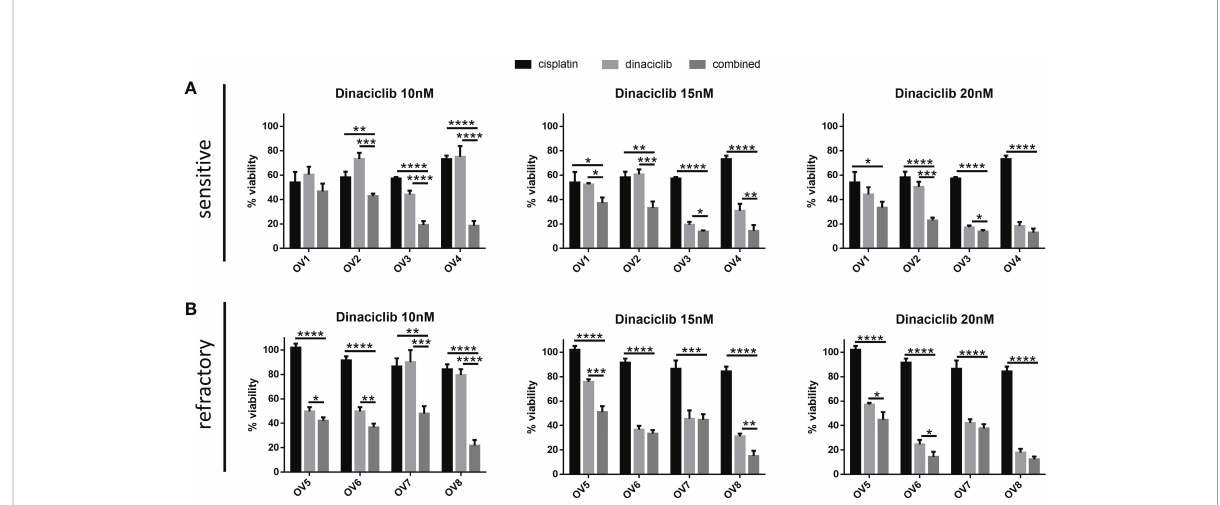
FIGURE 5 Dinaciclib combines additively with cisplatin in primary samples regardless of cisplatin sensitivity. Patient tumour cells isolated from platinum sensitive and refractory tumours were treated for 72 h either individually, or in combination, with 10 µM cisplatin and dinaciclib at concentrations of 10, 15 and 20 nM. Viability is expressed as a percentage of media controls. Results are grouped by (A) platinum sensitive samples (OV1-4) and (B) platinum resistant samples (OV5-8). Data are expressed as mean of three independent experiments with error bars representing standard deviation. Statistical signi fi cance was calculated by ANOVA followed by Dunnett ’ s test. *p value < 0.05, **p value < 0.01, ***p value < 0.001, ****p value < 0.0001.